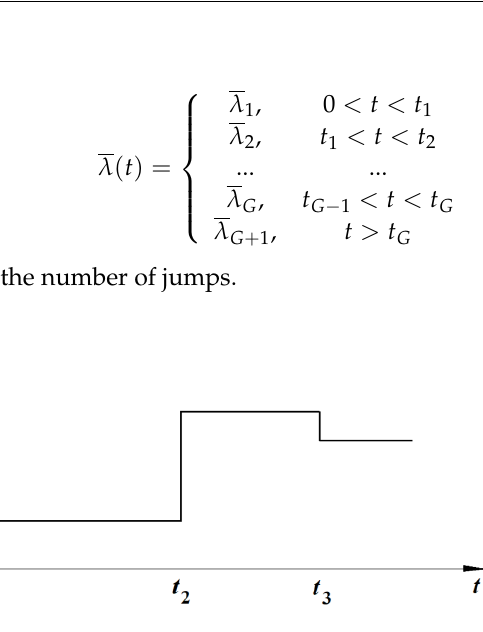
Figure 1. An example of the dependence of the intensity of additional information flow on